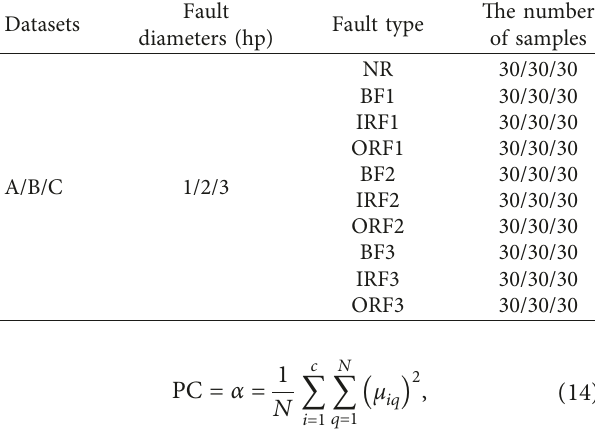
Table 1: The roller bearings experimental data under different